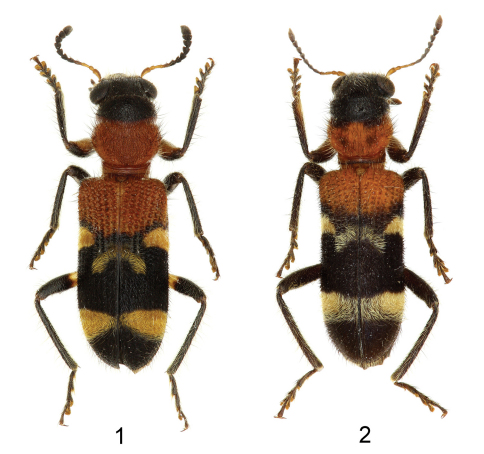
Habitus 1 Tillicera sensibilis sp. n., paratype, from Yingjiang, Yunnan 2 Tillicera wenii sp. n., holotype, from Lalashan, Taiwan.